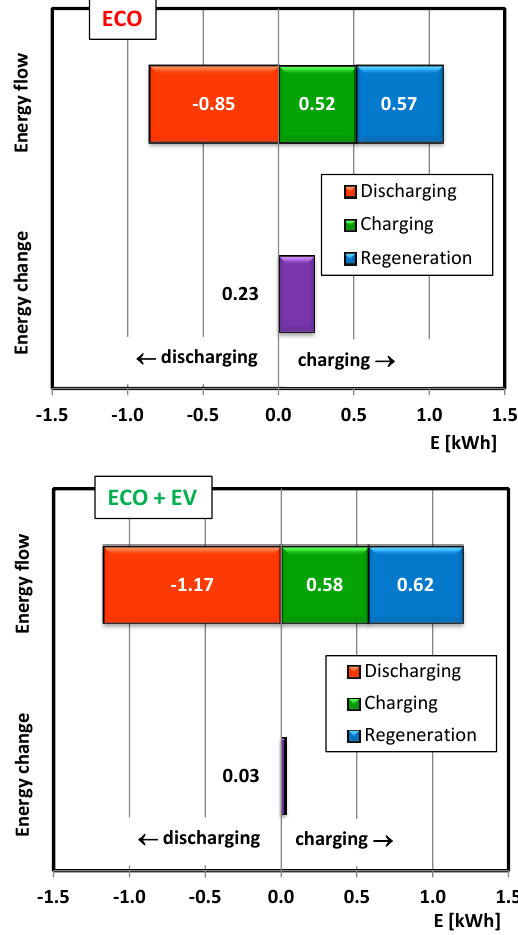
Fig. 3. Energy flow to/from the battery in a hybrid drive in urban condi- tions (negative values indicate discharging the battery) From the data in Table 3 the operating time density of individual vehicle driving modes have been calculated. The results were presented in terms of both the time and the distance traveled (the differences in the result are from the vehicle's